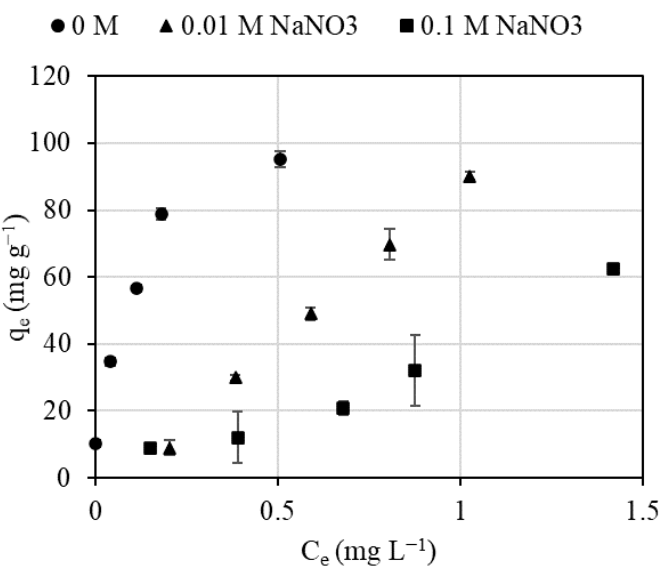
Figure 3. Evolution of adsorbed Pb (II) concentration on Spirulina for different ionic strengths (ex- perimental conditions: S/L: 50 mg L − 1 , contact time: 72 h, pH: 5.2).